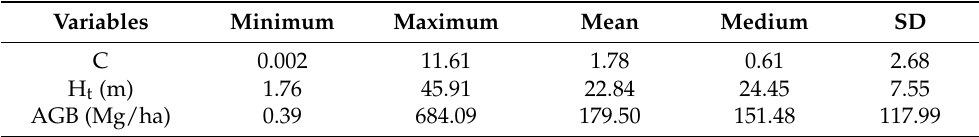
Table 5. Statistical descriptions of the LiDAR-derived canopy cover (C) and height (H t ) as well as AGB.